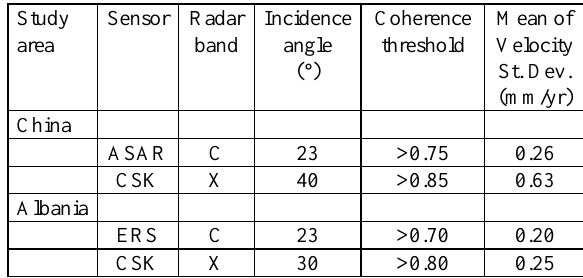
Table 1. Specifications for SAR datasets and processing